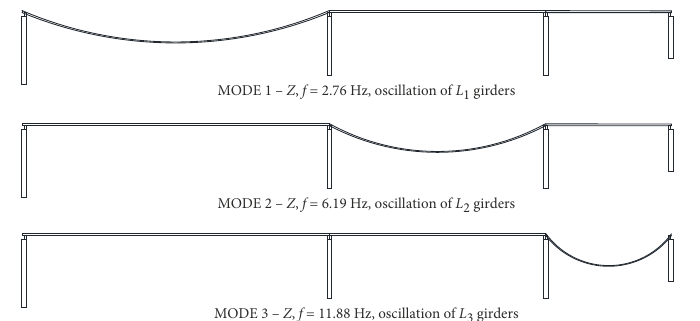
MODE 1 – Z , f = 2.76 Hz, oscillation of L girders